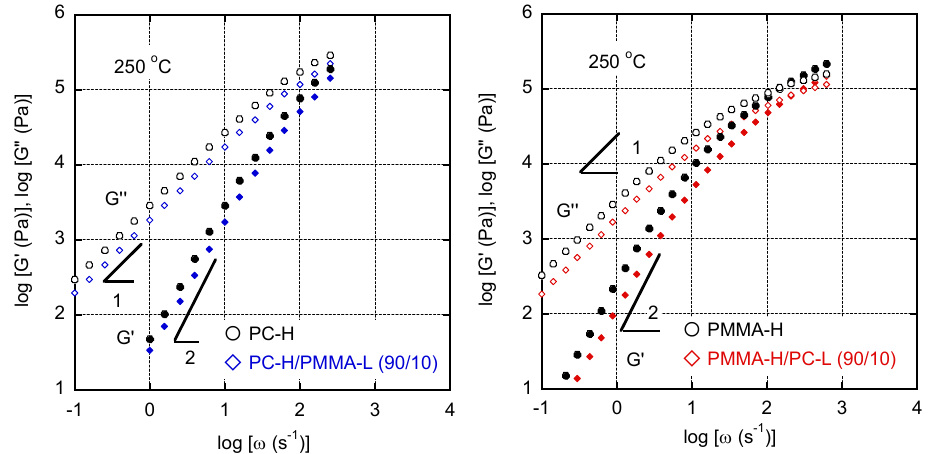
Figure 5. Angular frequency w dependence of the oscillatory shear moduli, i.e., the storage modulus G’ and the loss modulus G” , at 250 °C of ( left ) PC-H and PC-H/PMMA-L (90/10) and ( right ) PMMA-H and PMMA-H/PC-L (90/10).